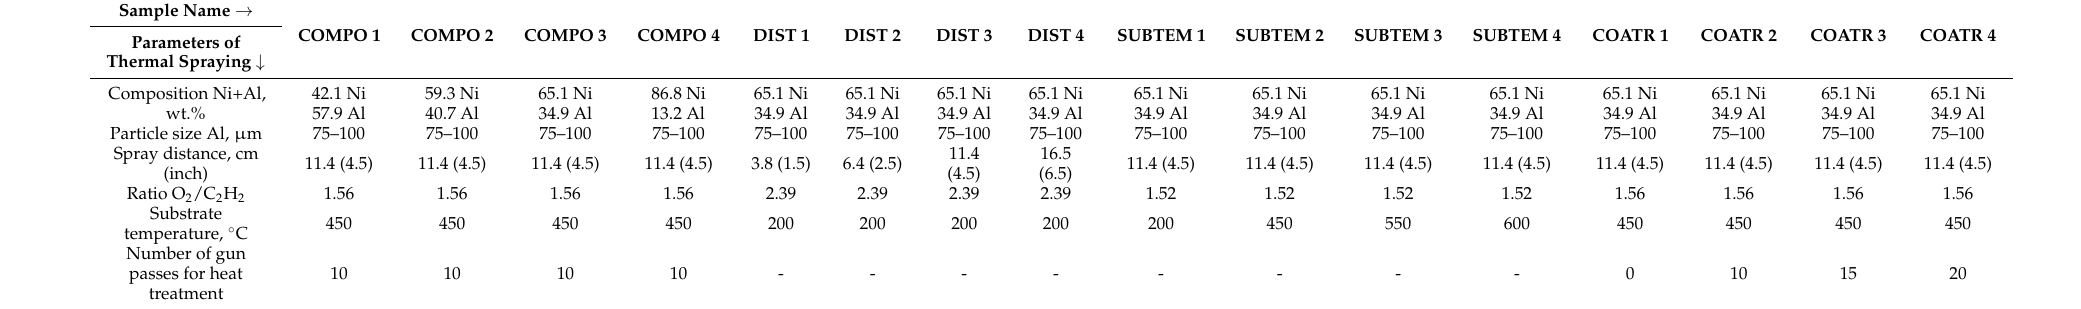
Table 1. Parameters of thermal